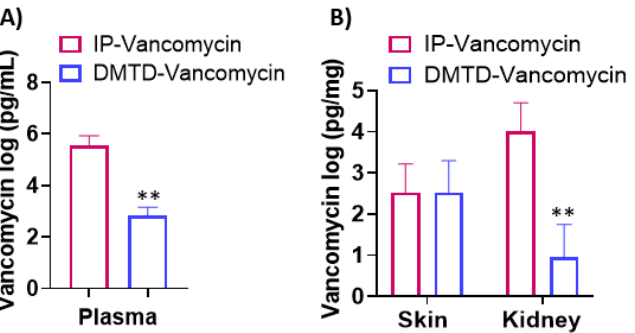
Figure 11. Vancomycin levels in ( A ) Plasma and ( B ) skin and kidney when the drug was delivered by either systemic IP or localized DMTD delivery to mice. n = 3. ** p <